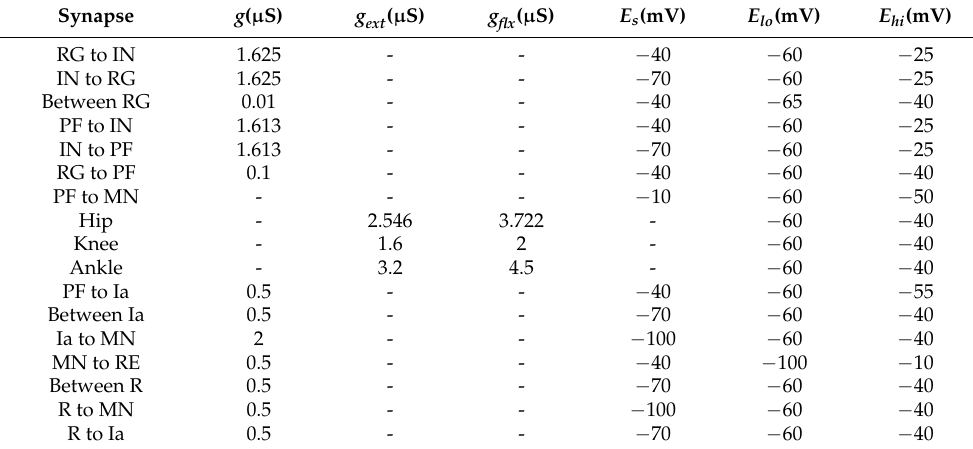
Table A2. Synapse parameters for 1 Hz